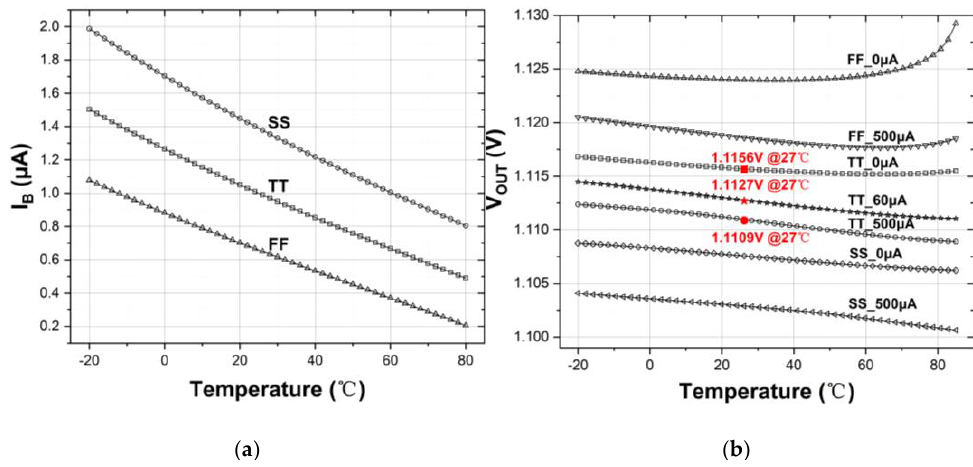
Figure 9. ( a )Temperature characteristic of I B ( T ); ( b )Temperature characteristic of V OUT ( T ).